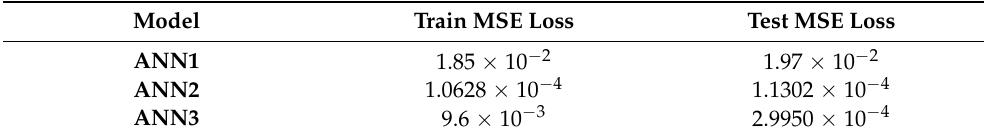
Table 3. Results of the three neural